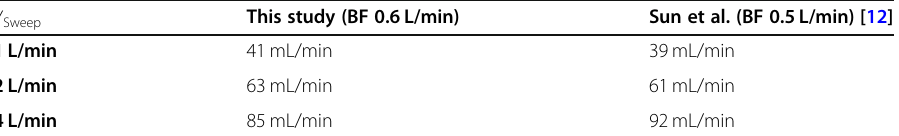
Table 3 Comparison of CO 2 removal rates of the pediatric oxygenator Quadrox iD for different blood flow (BF) and sweep gas flows ( ˙ V Sweep ) ˙ V Sweep